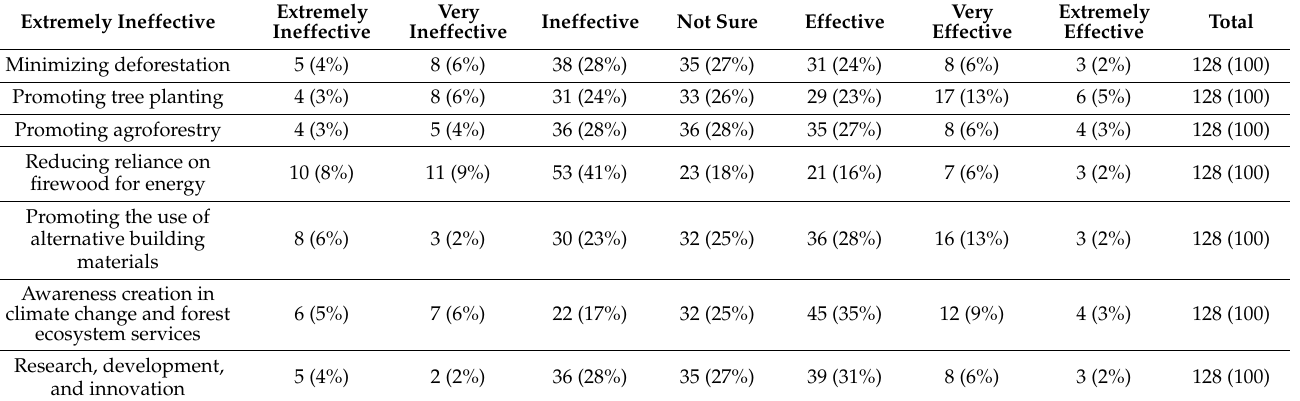
Table 3. Implementation strategies for policy instruments for climate change adaptation in mopane woodlands in northern